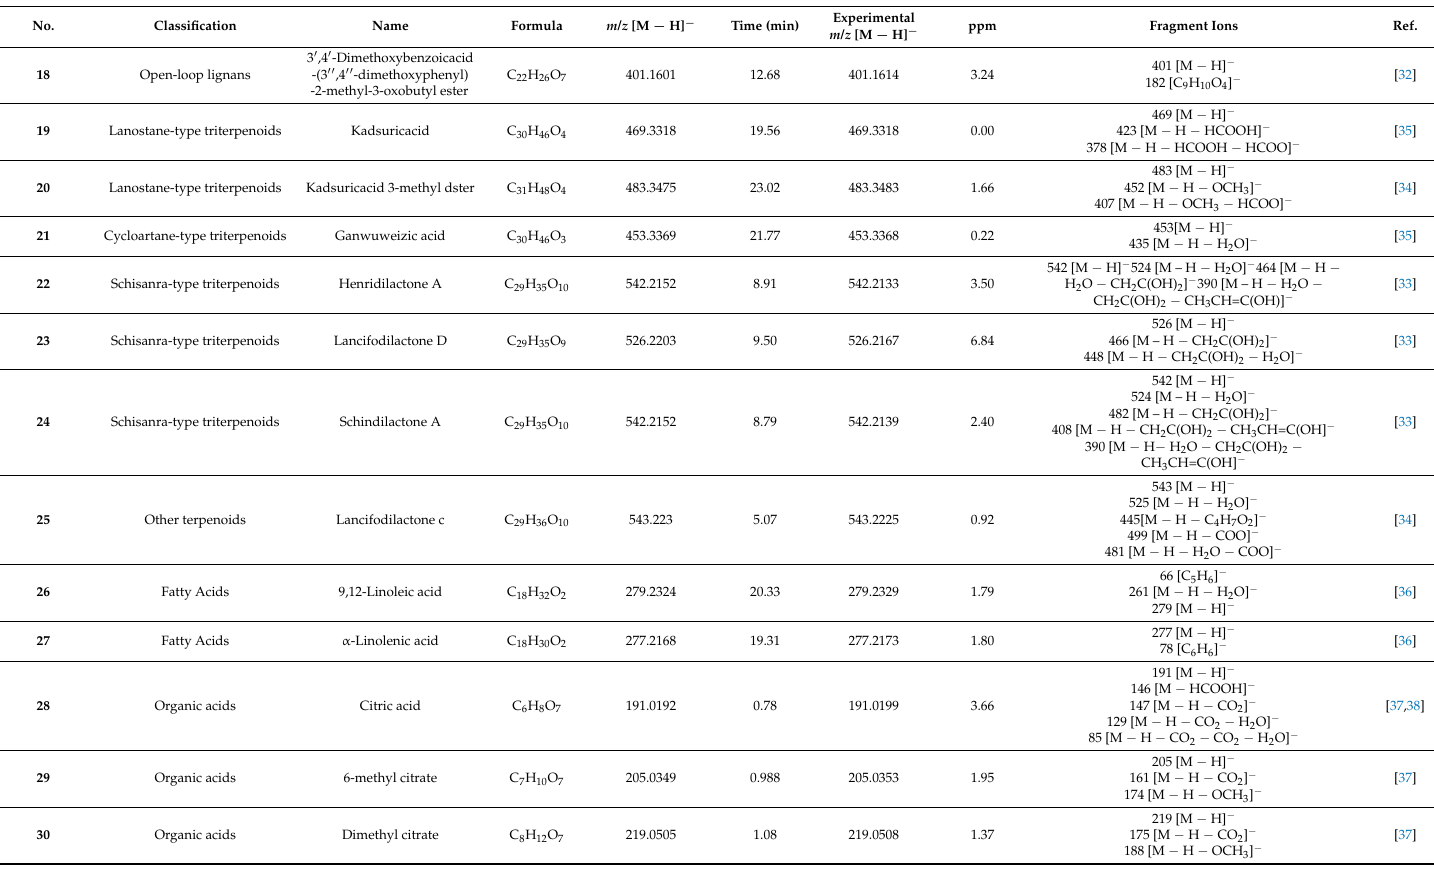
Table 3. Identification of the chemical constituents of the WWZ extract by using UPLC-Q-TOF/MS in negative ion modes.